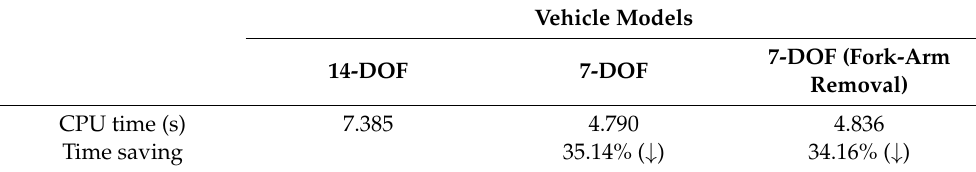
Table 5. Efficiency of different vehicle models in the 20 s simulation (sloping